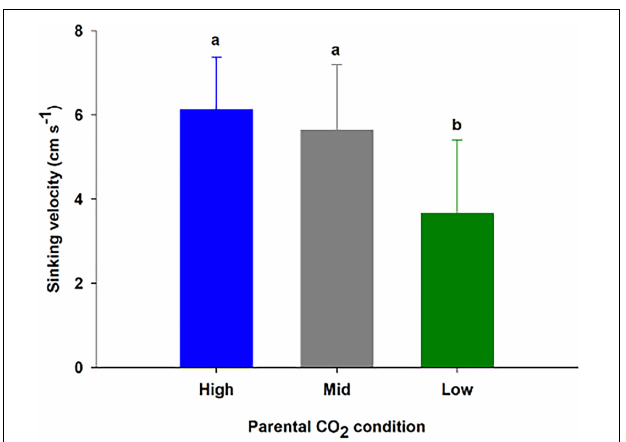
FIGURE 5 | Sinking velocity (mean ± SD) of 14–24 seeds produced from flowering shoots kept at three CO 2 conditions (high, mid and low) for 55 days (Experiment 3). Conditions correspond to a pH T of 6.96, 7.54, 8.13 ( Supplementary Table 3 ). The different letters above bars represent statistical differences between conditions as specified by the results of a Tukey’s pairwise comparison test following significance from a one-way